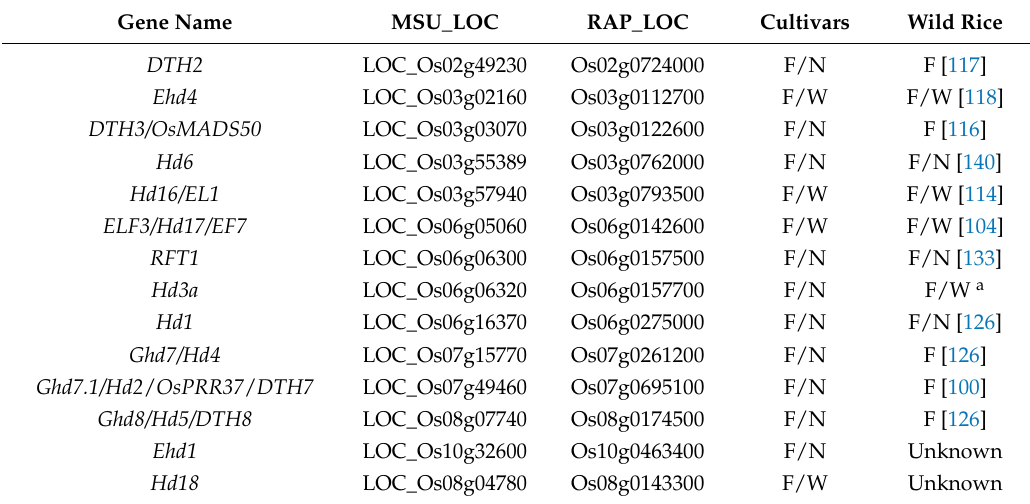
Table 2. Functional and non-functional alleles of flowering genes in cultivars and wild